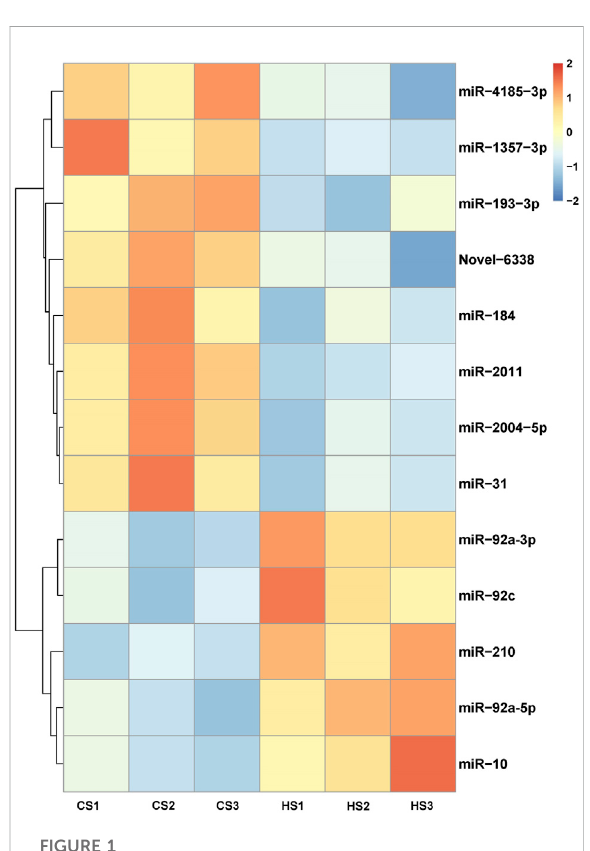
FIGURE 1 Cluster analysis heatmap of differentially expressed